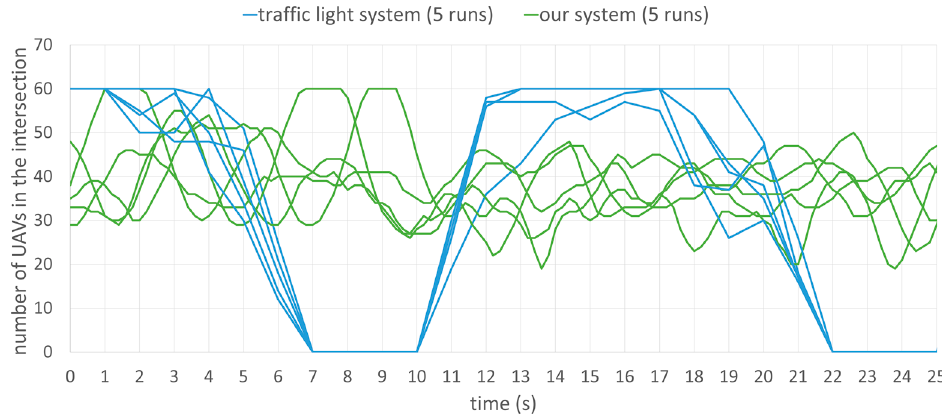
Figure 27. Number of UAVs in the intersection for Scenario 1 when arrival rate is 200 UAVs per minute. Scenario 2: UAVs can turn left, move straight, or turn right in the